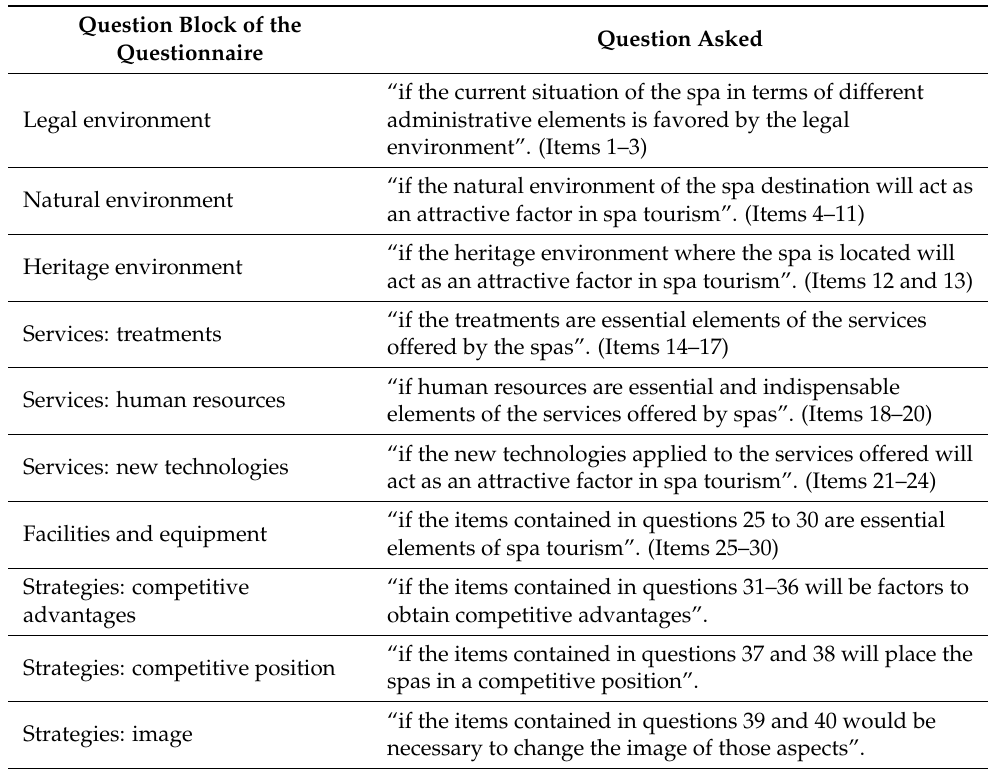
Table 4. Questions posed to the experts.